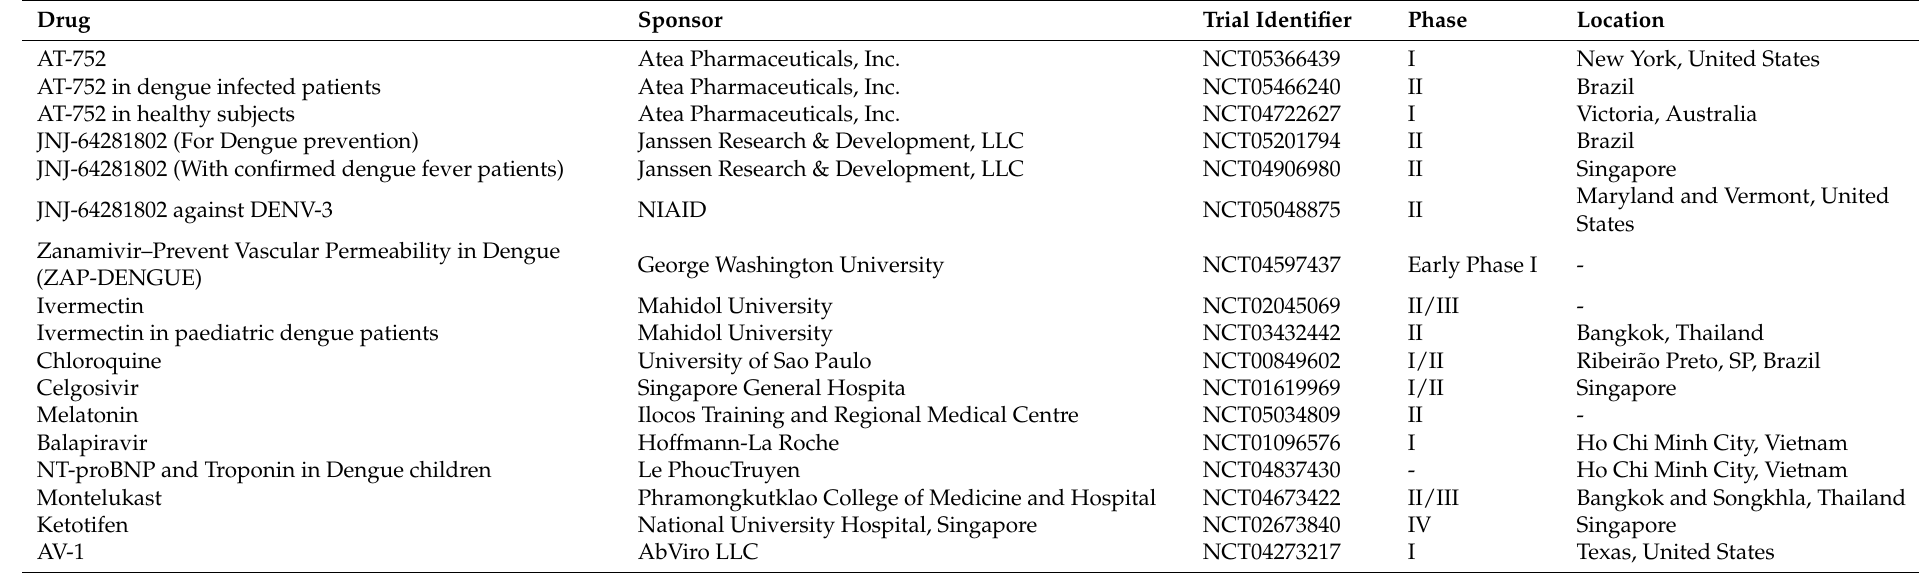
Table 2. Current status of drugs for dengue fever under clinical trials (source: ClinicalTrials.gov, accessed on 8 October 2022).